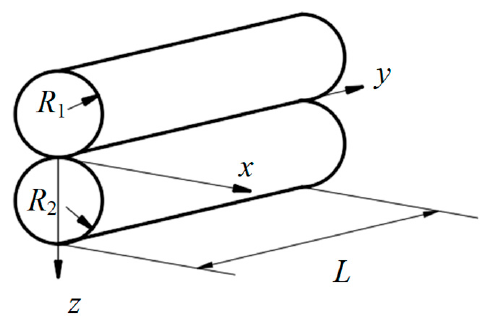
Figure 4. Two elastic cylinders in parallel contact.